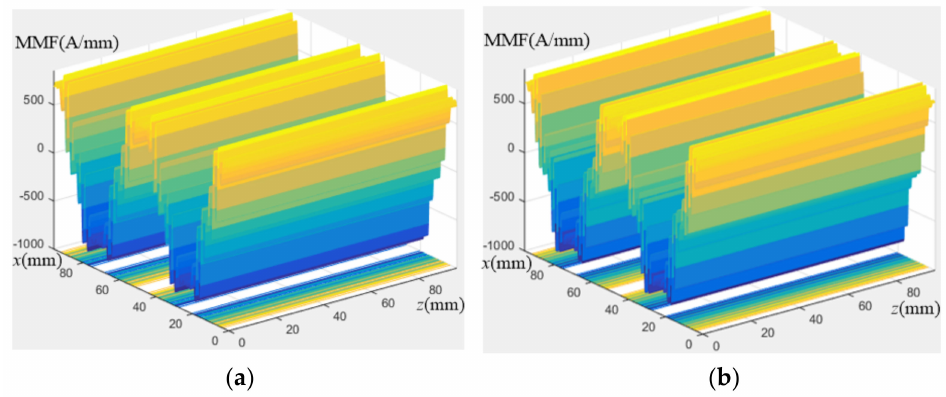
Figure 3. MMFs of the PM width-modulation array: ( a ) s = 9, ( b ) s =